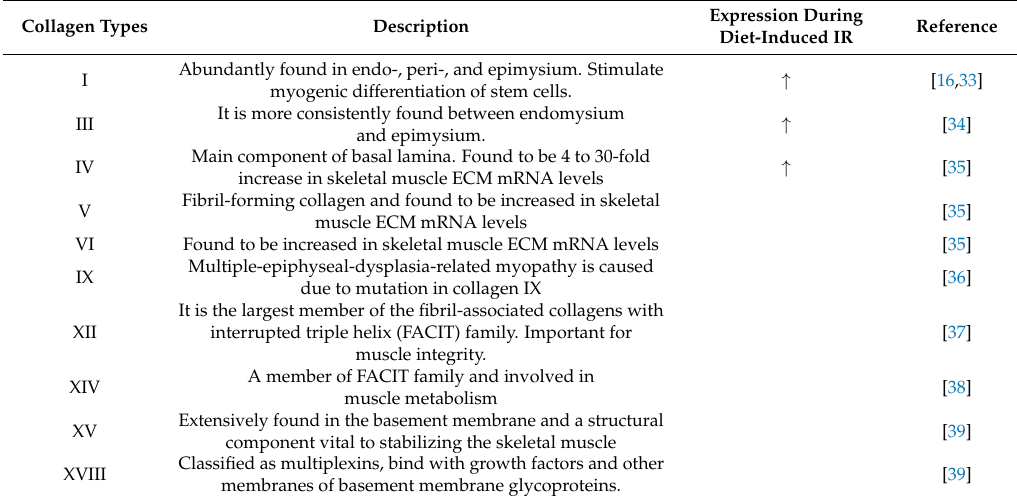
Table 1. Major types of collagens in skeletal muscle